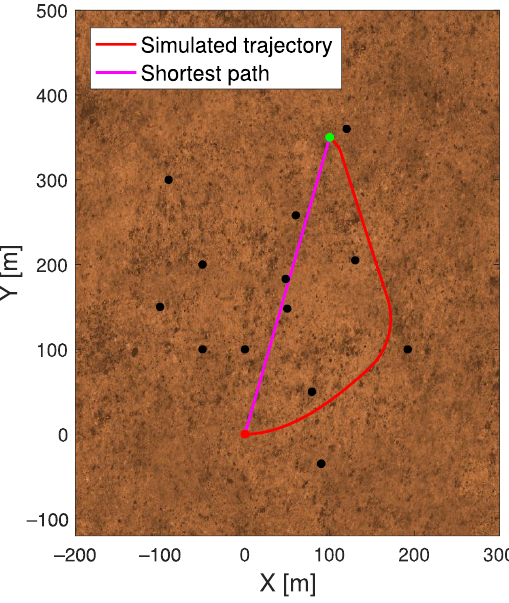
Figure 10. Simulated rover’s trajectory vs . shortest path. The initial coordinates of the rover and the final target are marked in red and green, respectively. The obstacles are marked in black.